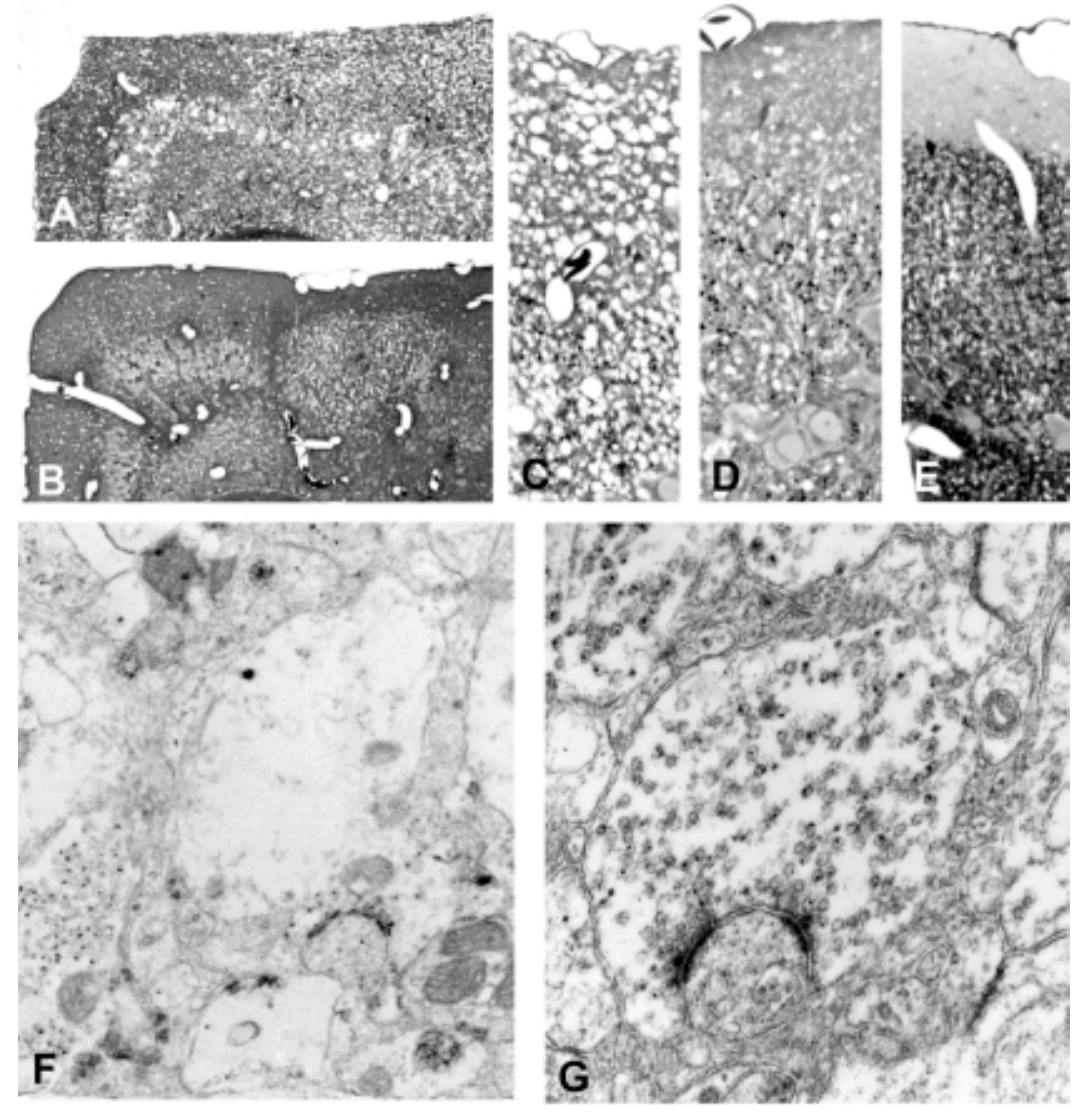
Fig. 7 – Lesion and regeneration of the medial cortex zinc positive axonal projection. A: Semithin section of the medial cortex of a lizard 1 day after 3AP injection; observe the dramatic swelling suffered by the cell layer and the plexiform layers (both zinc positive and zinc negative strata). B: Idem, four days after 3AP injection; observe that the oedematous appearance has disappeared from the zinc negative areas but in the zinc positive ones plenty swollen dendritic and axonal profiles still appear. C-E: Aspect of the dorsomedial outer plexiform layer in lizards sacrificed 1 day (C), 4 days (D) and 34 days (E) after 3AP lesion in Timm stained semithin sections; observe the absence of Timm reaction one day after lesion, the presence of some puncta-like positive spots four days after lesion (D) and the abundance of them in the almost completely regenerated area 34 days afterwards (E). F-G: Ultrathin section of zinc positive boutons in the outer plexiform layer of the dorsomedial cortex four days (F) and 10 days (G) after 3AP lesion; observe that on day 4 after lesion the zinc positive bouton appears swollen but still making a synaptic contact with a dendritic spine and that on day 10 after lesion it displays a completely normal appearance. (Scale bar represents 150 µ m in A and B, 40 µ m in C-E, 5 µ m in F and 3 µ m in G).